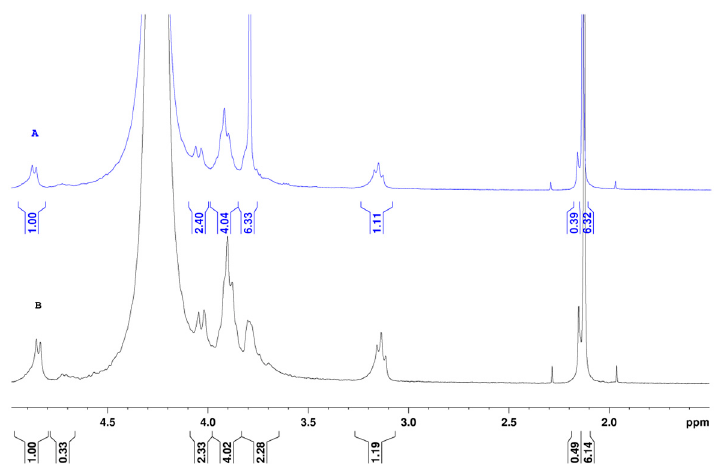
Figure 5. 1 H-NMR spectrum for the CS-102/PEO (80/20) mixture solubilized in 0.5 M acetic acid with added D 2 O ( A ) and CS-102 solubilized in 0.5 M acetic acid with added D 2 O ( B ). After electrospinning, the fibers were maintained at ambient conditions for one week; excess of acetic acid and water were evaporated to stabilize the material. Then, the composition was investigated after dissolution in D 2 O in acid conditions (DCl) (Figure 6). Firstly, a chemical shift was noted for all the signals compared with those obtained in acetic acid (+0.2 ppm in DCl) and inversion in the respective chemical shifts of the –CH 3 of acetyl groups (at 2.15 ppm) and residual acetate salt from acetic acid (at 2.18 ppm).